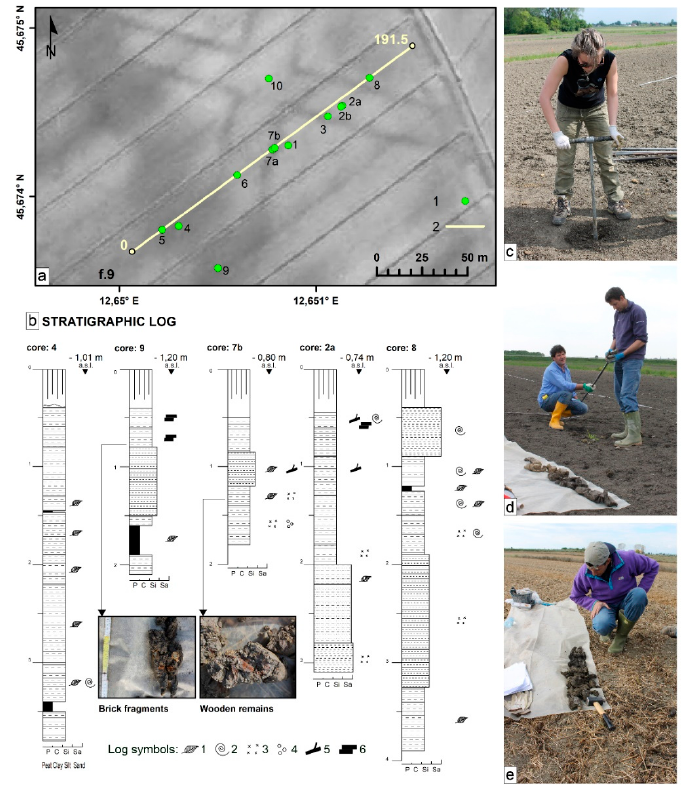
Figure 7. Drilling. ( a ) Location ofthe cores: (1) andERT alignment (2). ( b ) Stratigraphic logs of core drillings performed in correspondence of paleochannels (4, 9, 8), ditches (7b), and main axes of the presumed stractures of ancient origin (9, 2a). Log symbols: (1) fragments of plant remains; (2) continental mollusks; (3) carbonatic nodules; (4) nodules of iron-manganese oxides; (5) charcoal; (6) bricks fragments. On the right, from top to bottom, photos of the works: ( c ) execution of a core; ( d ) sampling of a core; ( e ) documentation of stratigraphic